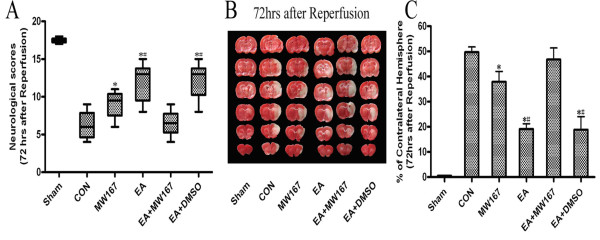
Neurological scores (A) and infarct volumes (B, C) at 72 h after reperfusion in the rats. Pretreatment with EA significantly improved the neurological scores and reduced the infarct volume while the γ-secretase inhibitor MW167 abolished the protective effect of EA pretreatment. Treatment with MW167 in MCAO only animals also induced neuroprotective effect. (*P < 0.05 vs. CON; #P < 0.05 vs. MW167).